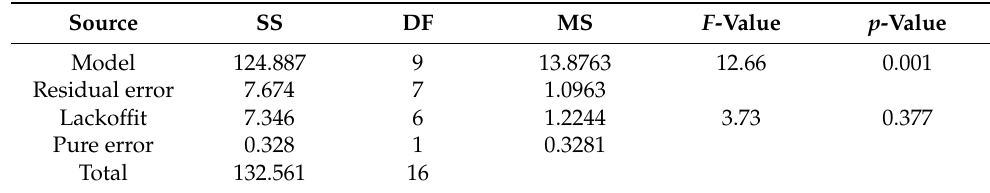
Table 6. Analysis of variance (ANOVA) for the parameters of response surface methodology fitted to quadratic polynomial model for optimization of potentiation of PG